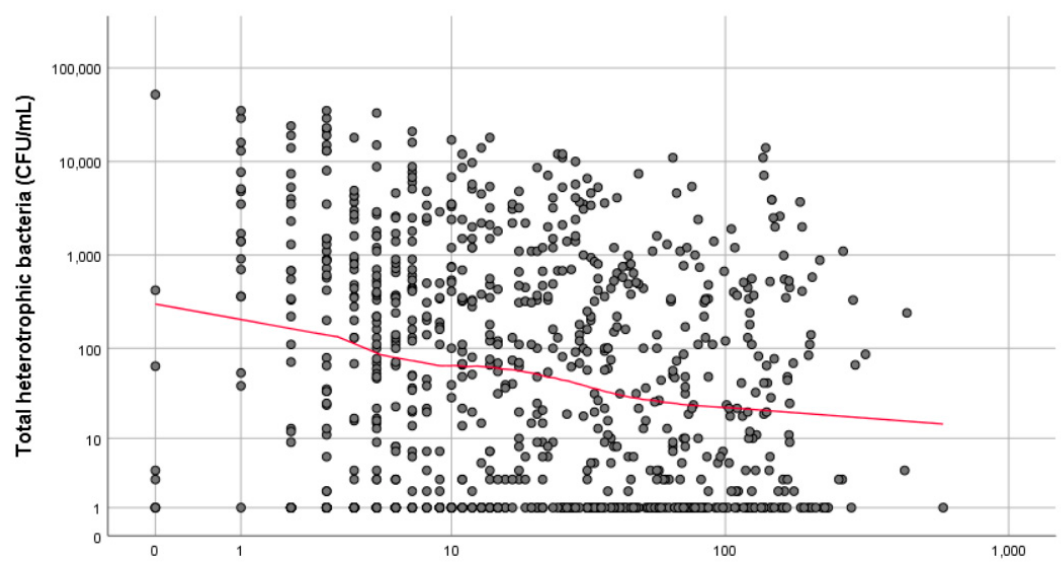
Figure 2. Simple scatter plot with loess line of fit showing the association between total heterotrophic bacteria (CFU/mL) and the total number of flushing events during the 7 days prior to sampling.